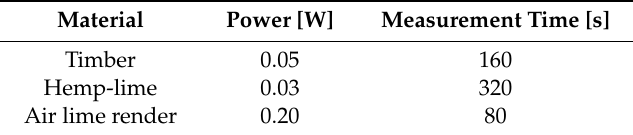
Table 3. Power and measurement time for the measurements of thermal conductivity using TPS1500, Hot Disk ® .